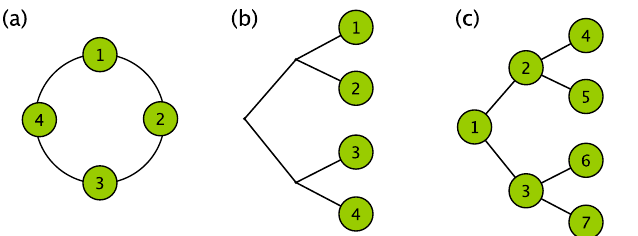
Fig 5. Cyclic and tree-structured symmetries. (a) A cyclic symmetry structure is one that remains invariant under a shift of all the variables (around the circle in the figure shown) that preserves their relative ordering. This cyclic symmetry defines the discrete Fourier transform. (b) A tree symmetry structure is one that remains invariant under permutations within groups and permutations of groups. This symmetry gives rise to ANOVA for nested pairs and also defines the Haar wavelet transform. It is applicable when it is just the leaf nodes that are of interest. (c) When all the nodes of a tree are of interest, the underlying symmetry is still that for the tree. The associated transformation is derived in this paper and discussed in the next